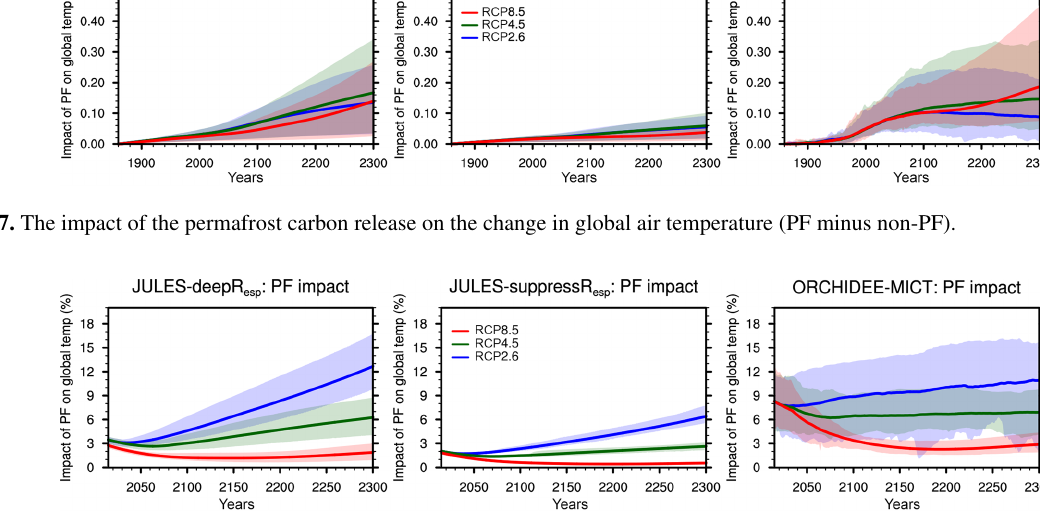
Figure 8. The percentage impact of the permafrost carbon feedback on the global mean air temperature change ( (cid:49)T ).